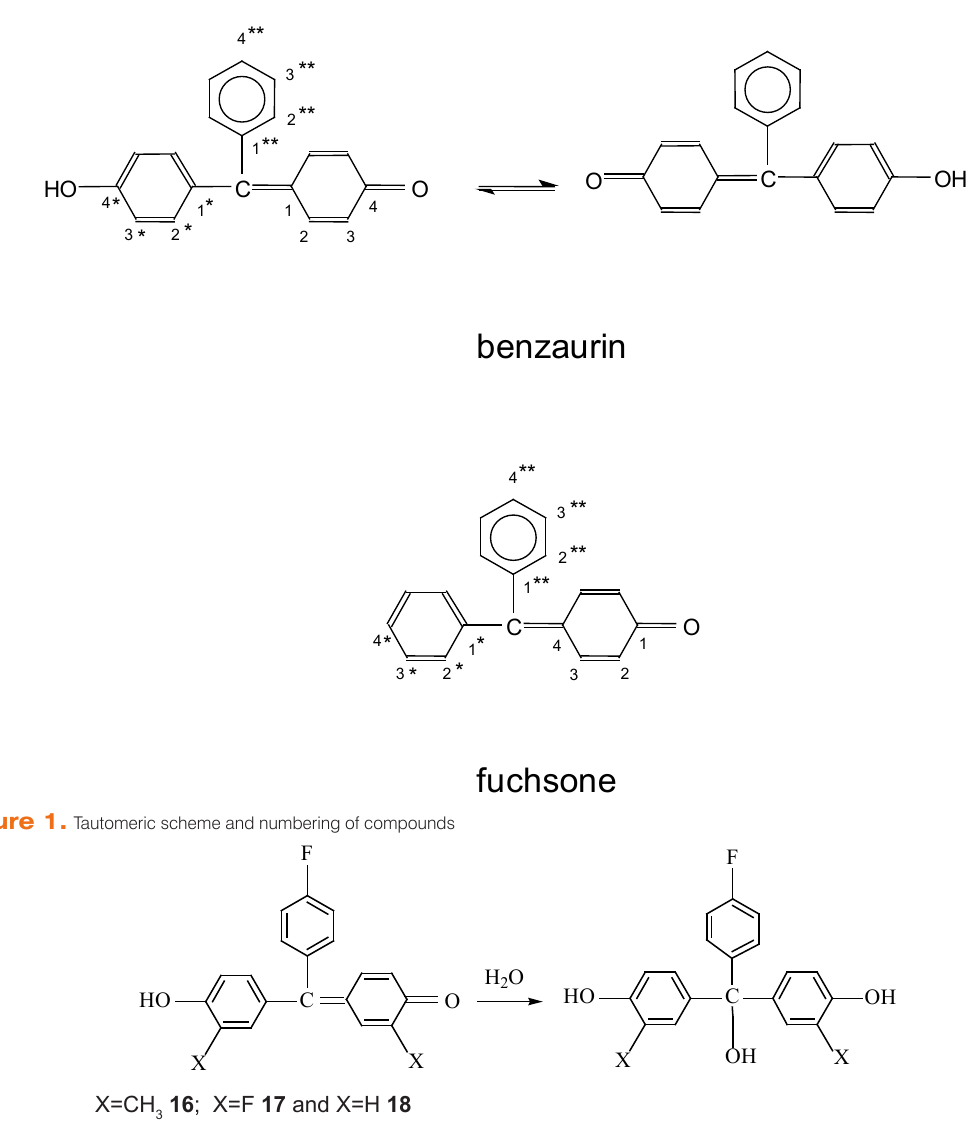
HO X X X=CH 16 ; X=F 17 and X=H 18 3